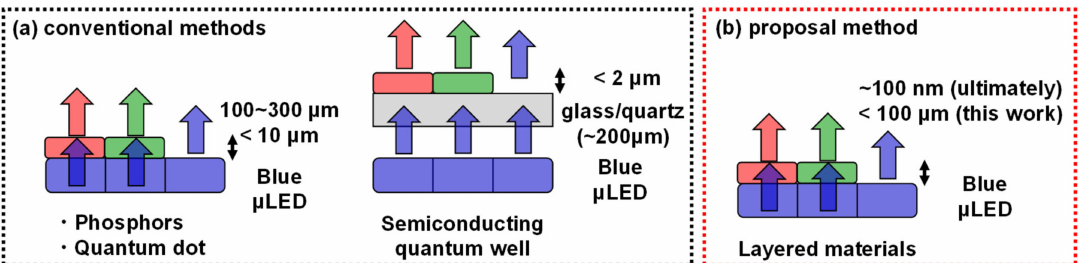
Figure 1. ( a ) Schematic diagrams of a conventional method for emission-color conversion of gallium nitride (GaN)-based micro light-emitting diodes ( µ LEDs) from blue to green and red. Phosphors and quantum dots (QDs) as color converters can be directly coated on GaN-based µ LEDs. The thicknesses of phosphorus and QDs are approximately 100 and 10 µ m, respectively. II-VI based quantum wells (QWs) are placed on GaN-based µ LEDs through a transparent carrier substrate (glass or quartz). Total thickness of QWs structure is below 5 µ m, however, the carrier substrate is at least 200 µ m. ( b ) Schematic diagram of our proposal for emission-color conversion of GaN-based µ LEDs from blue to green and red. Additionally, layered materials can be directly placed on GaN-based µ LEDs. The thickness of layered materials is below 100 µ m in this work. For future work, the thickness expects to be ultimately reduced to the order of a few tens